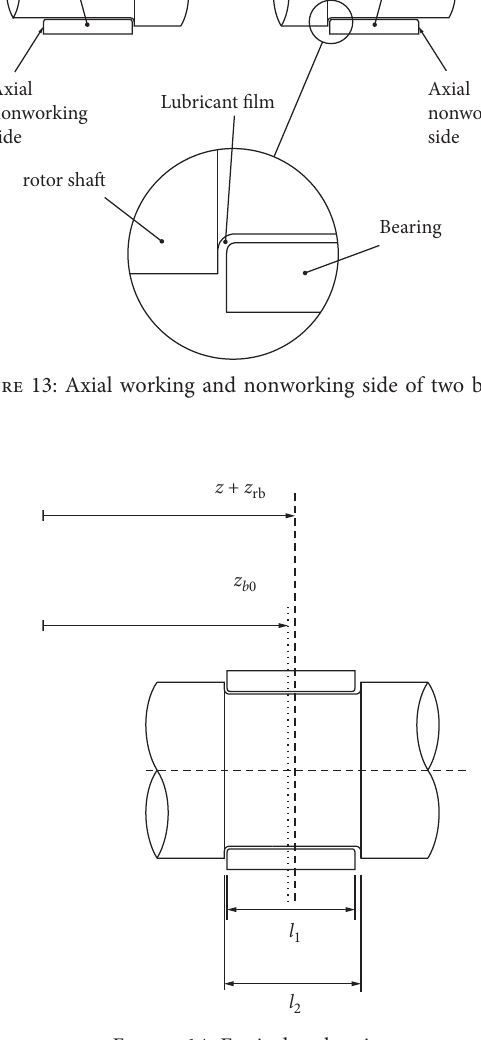
Figure 14: Equivalent